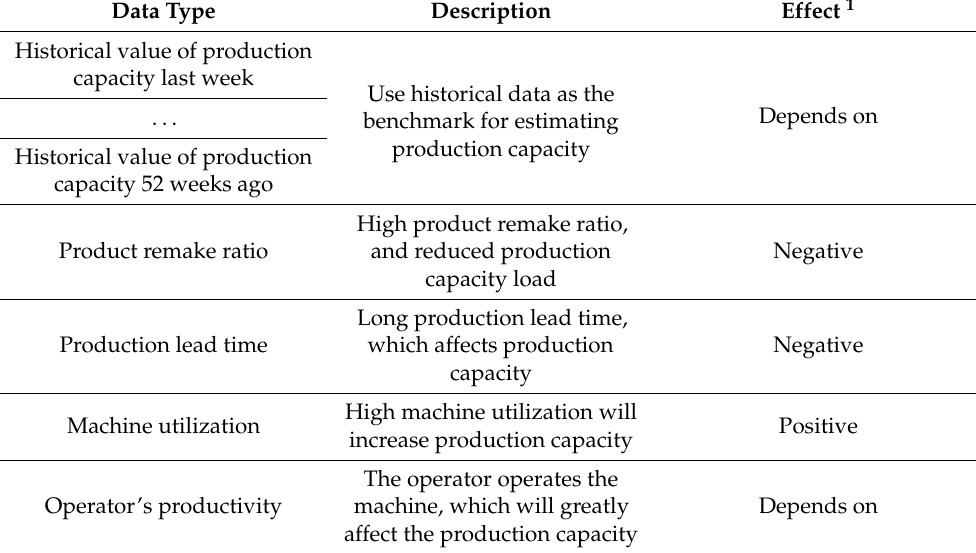
Table 1. Characteristic data for estimating production